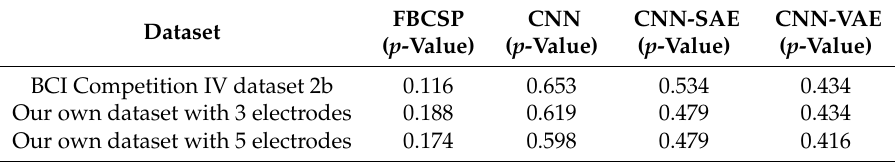
Table 5. The results difference to a normal